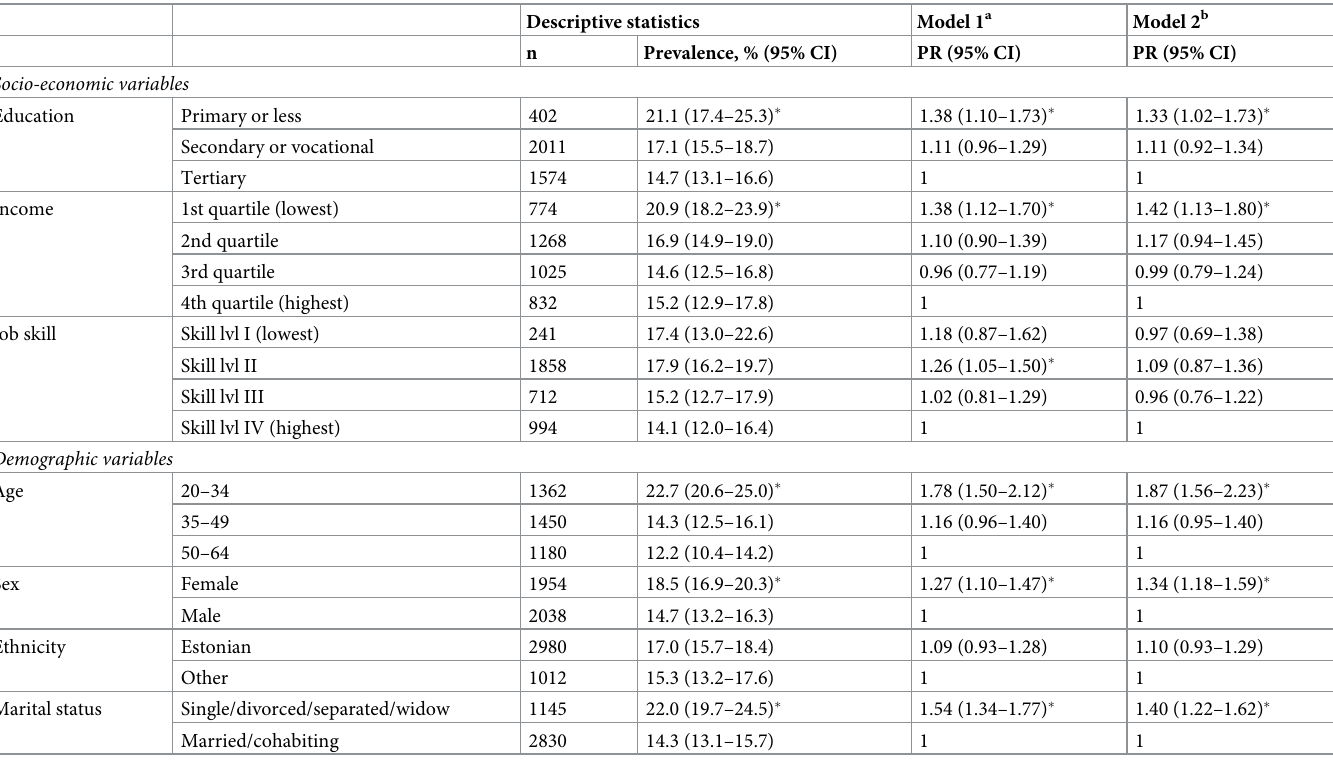
Table 2. Perceived depressiveness and association with socio-economic and demographic variables, descriptive statistics and prevalence ratios with 95%